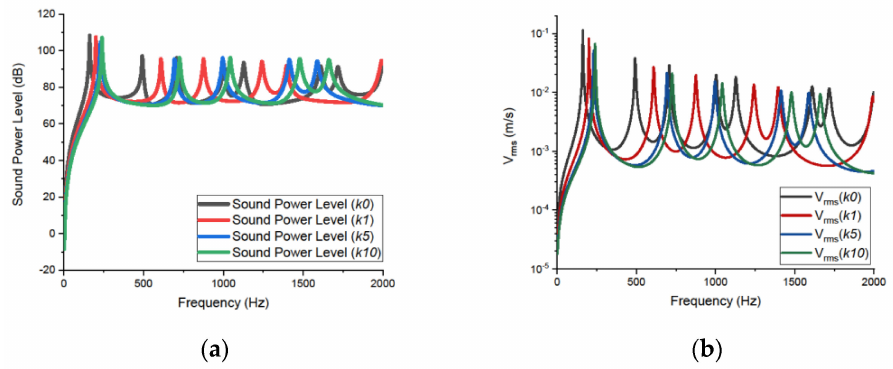
Figure 6. ( a ) SPL and ( b ) V_rms of clamped P-FGM plates for different k